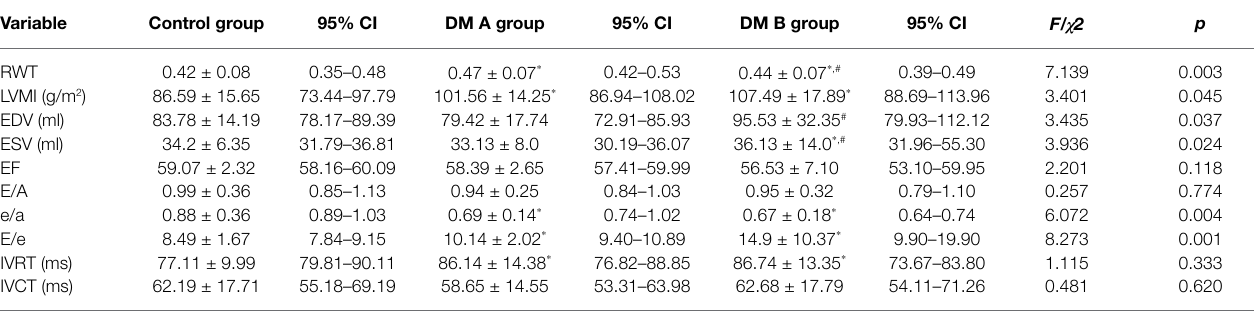
TABLE 2 | Echocardiographic parameters of the three groups.